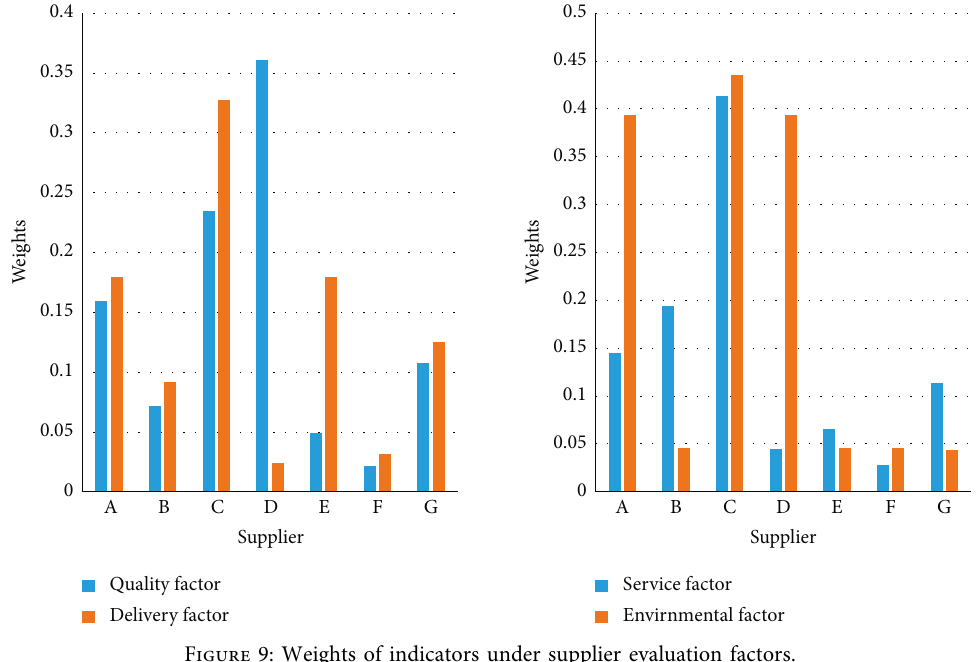
Figure 9: Weights of indicators under supplier evaluation factors.